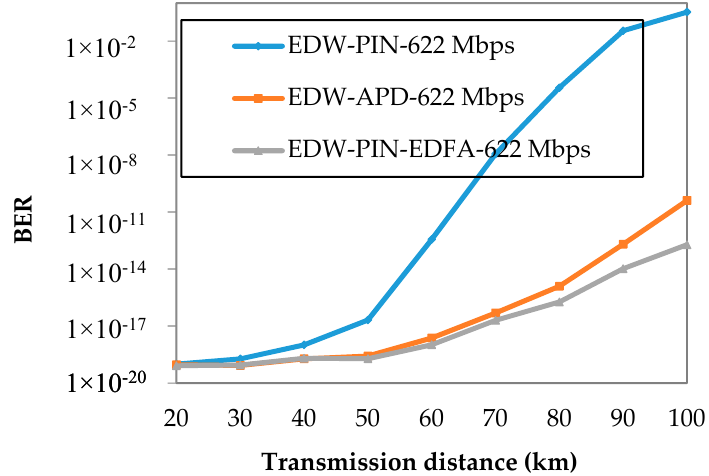
Figure 7. BER with transmission distance of SAC-OCDMA system using EDW codes with APD detector, PIN detector, and PIN detector in the presence of EDFA.